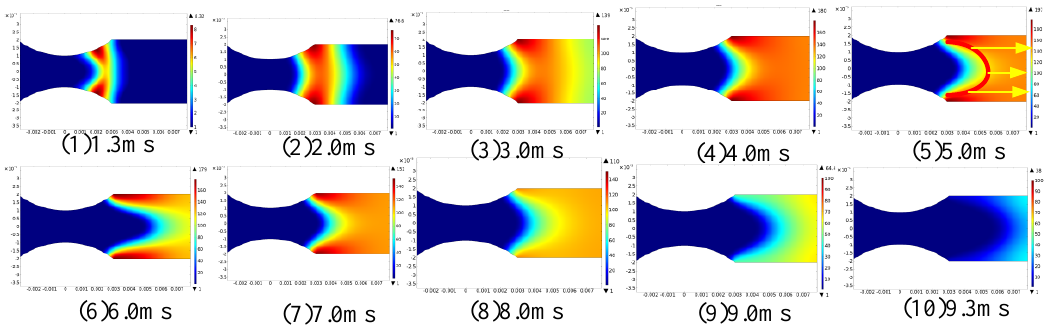
Figure 3. Arc motion characteristics in SSAC at different times.